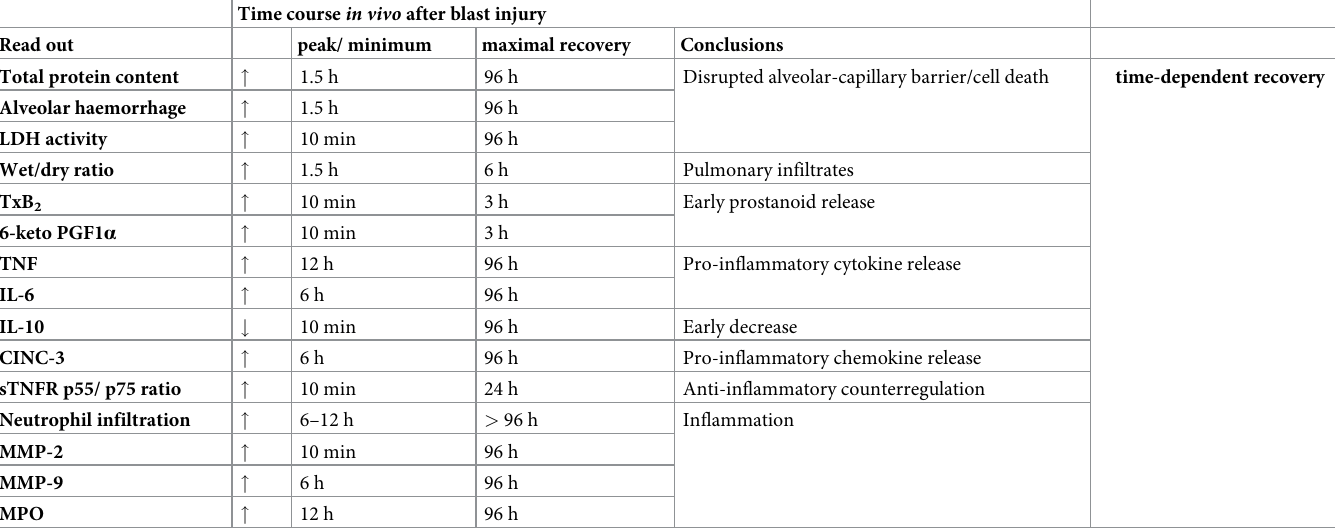
Table 1. Summary of time-dependent BAL findings compared to non-traumatized sham controls.